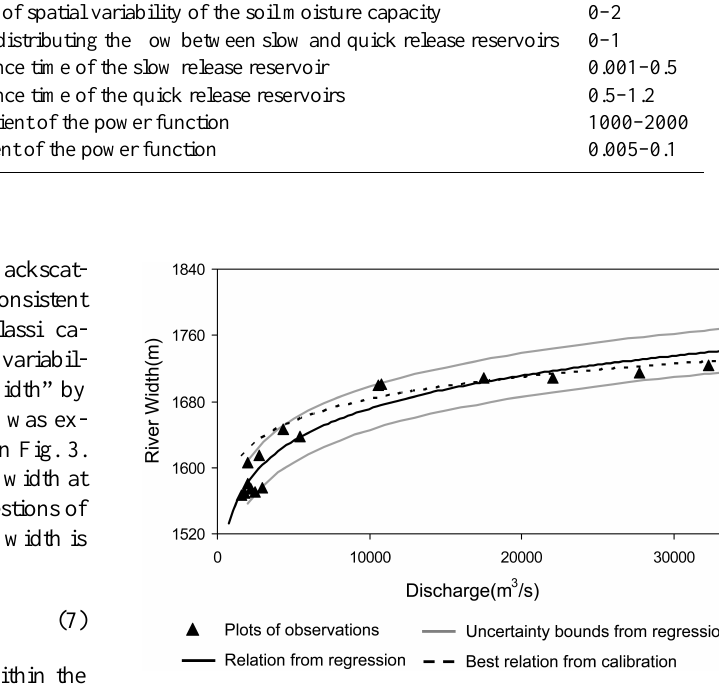
Fig. 4. Plots of effective width derived from JERS-1 SAR images versus river discharge measured at Pakse gauging station, the re- lation obtained from regression with uncertainty bounds, and best relation obtained from calibration based on river